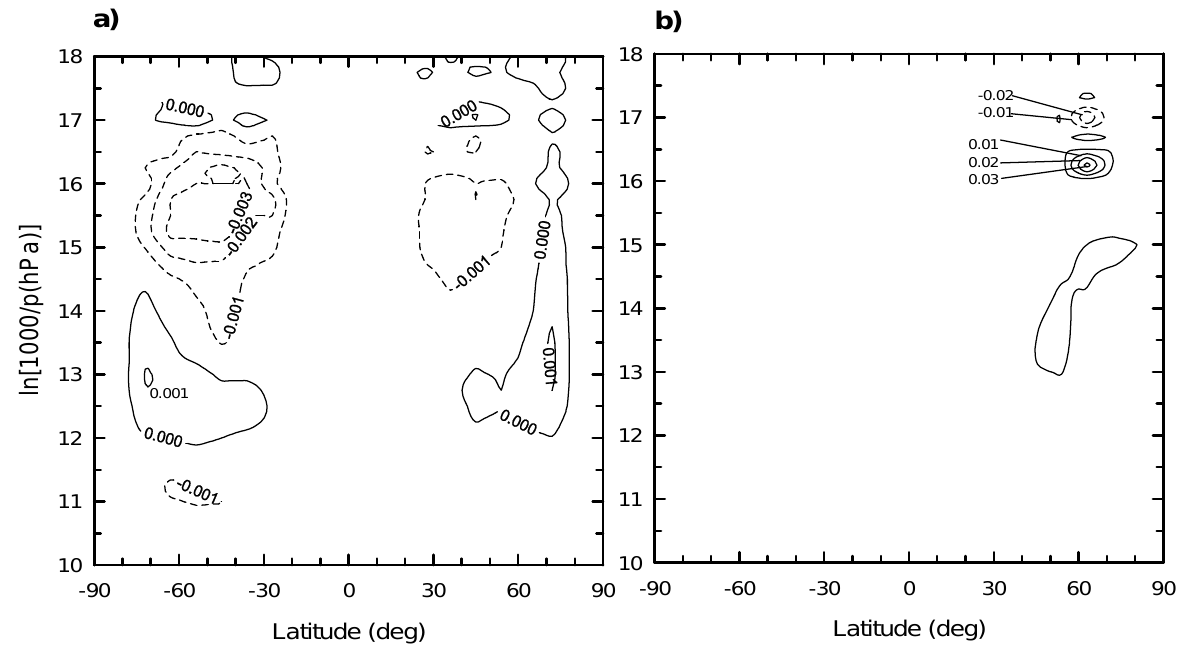
Fig. 11. As in Fig. 10, but for the 5-day wave.